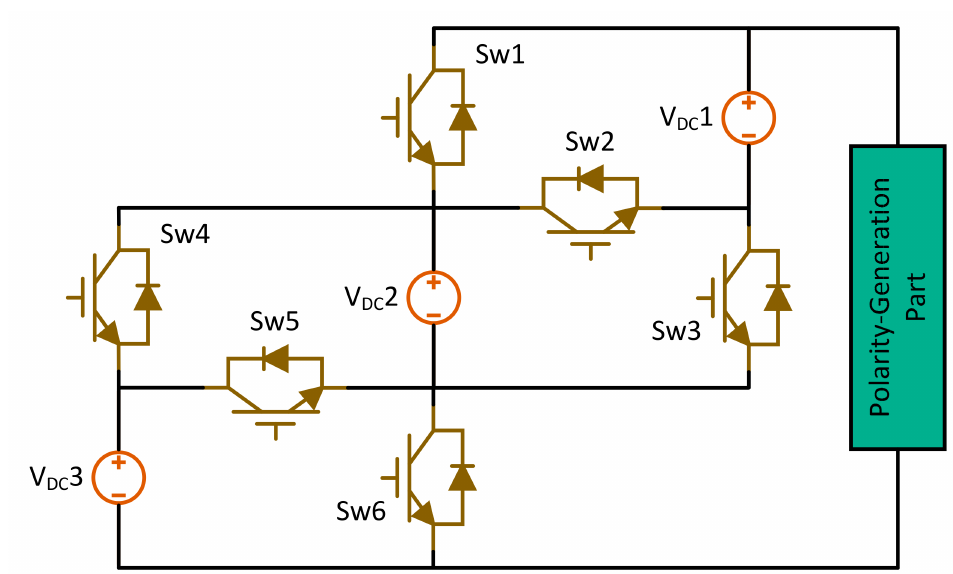
Figure 12. Topology of switched series/parallel sources based multilevel